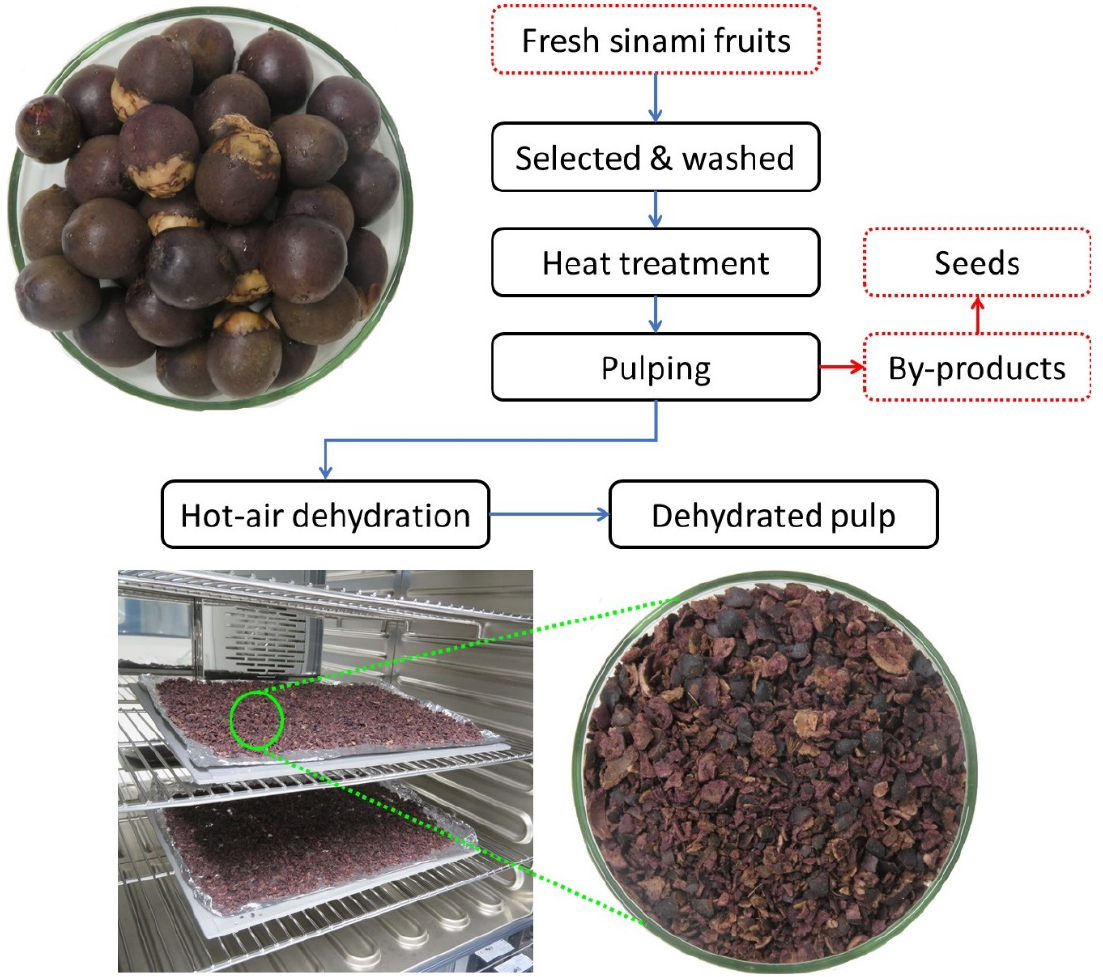
Figure 1. Flowchart of the process for obtaining dehydrated pulp from sinami fruit.